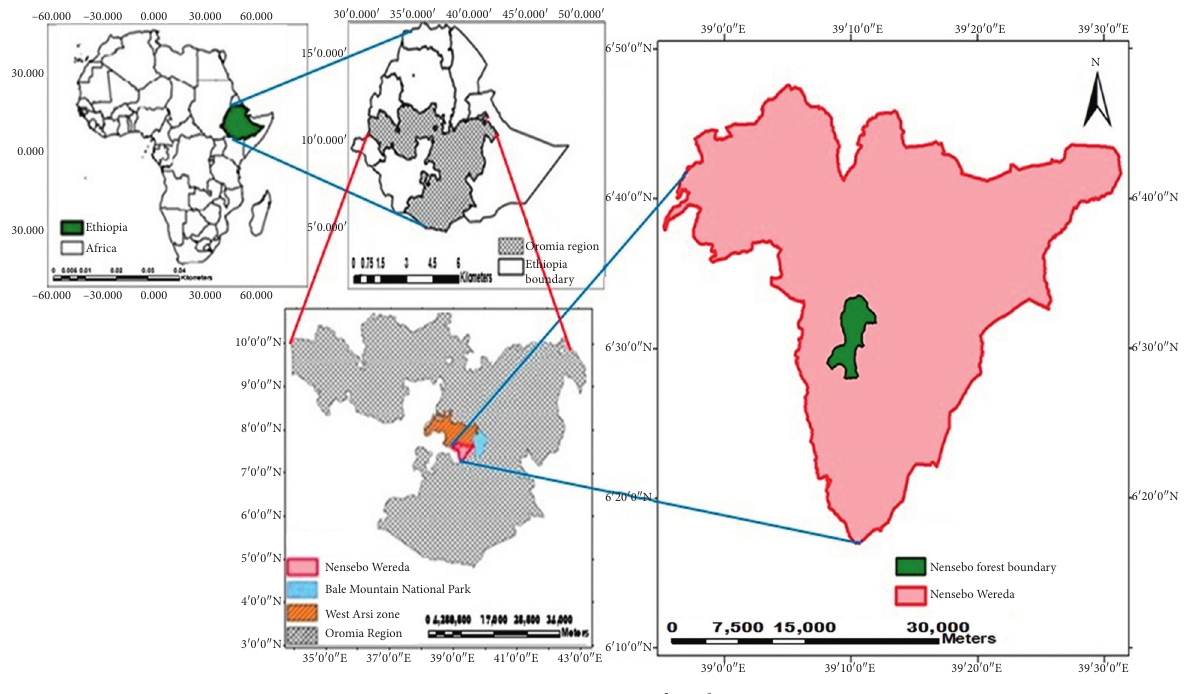
Figure 1: Location map of study area.